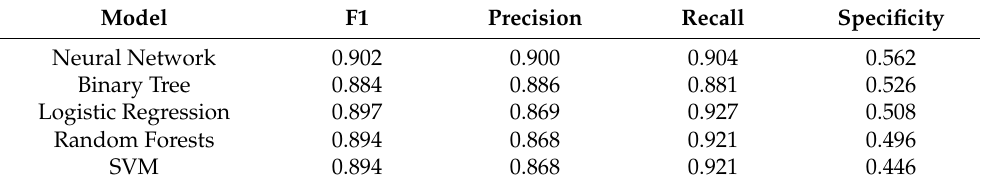
Table 16. Models accuracy metrics average over classes with add_to_cart_indirect as target parameter.